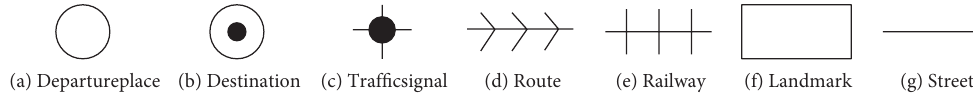
Figure 1: Object types and symbols.